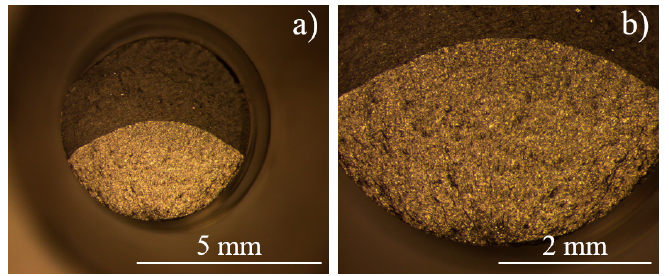
Figure 9. OM fracture images of aged Inconel 718 ( R = − 1, f = 20 kHz): ( a ) low zoom, ( b ) high zoom.